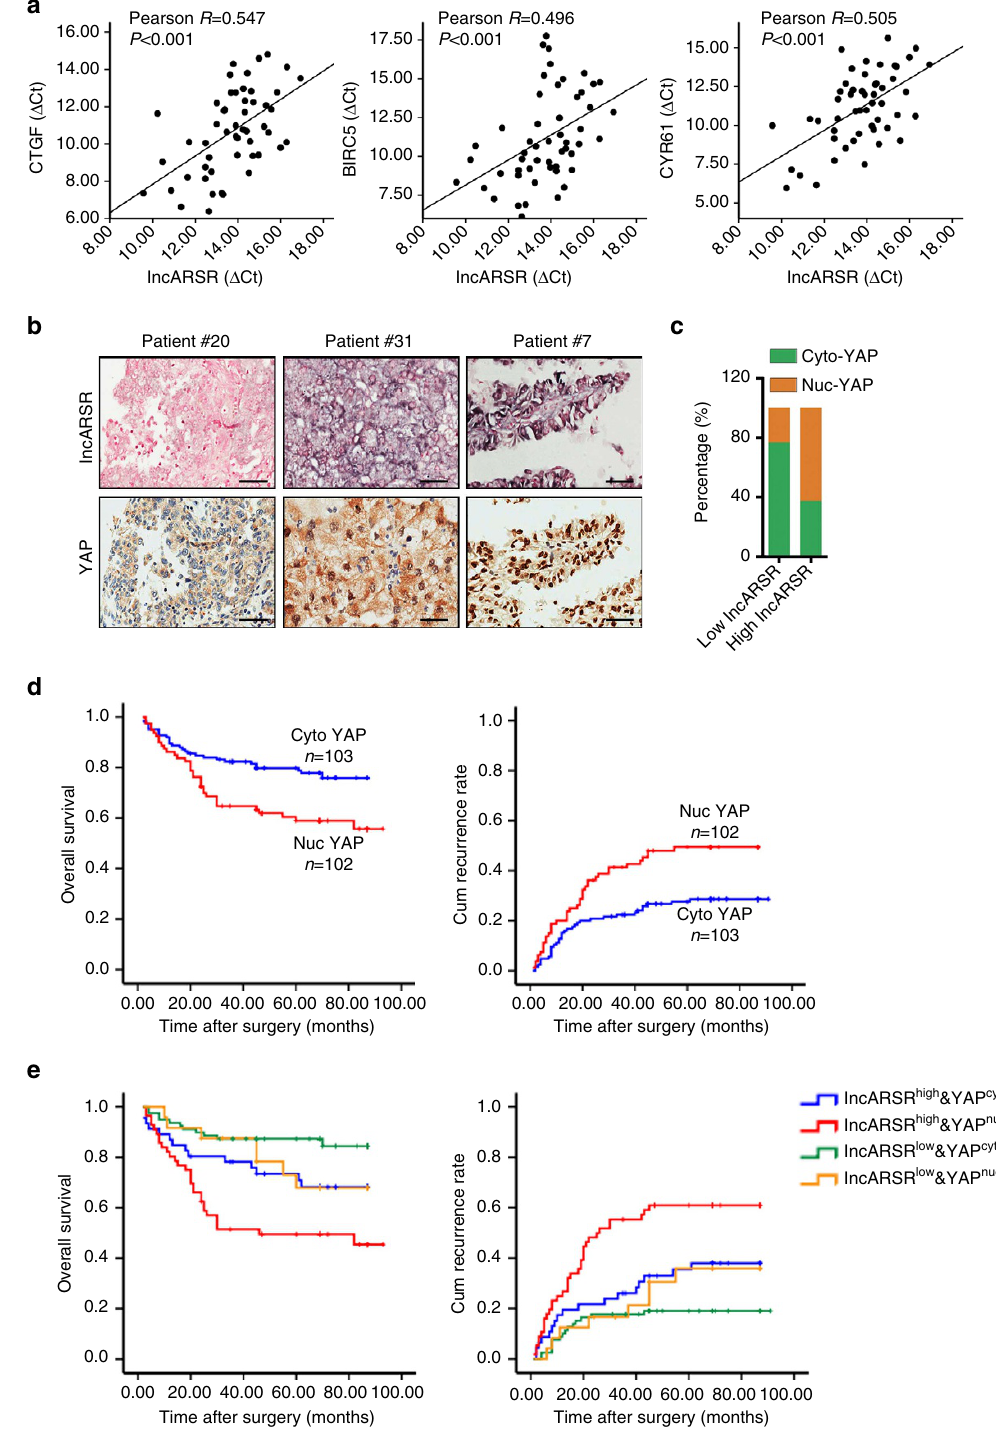
Figure 8 | Combining lncARSR and YAP exhibits improved prognostic value. ( a ) The correlation between the transcription level of lncARSR and CTGF (left), BIRC5 (middle) and CYR61 (right) in human ccRCC tissues ( n ¼ 52) was determined by qRT–PCR analysis. Data were normalized to b -actin as D Ct and analysed by Spearman’s correlation analysis. ( b ) Representative images of lncARSR ISH and YAP immunohistochemistry using consecutive sections of human ccRCC tissues. Scale bar, 50 m m. ( c ) Relative percentages of nuclear and cytoplasmic YAP in high (62.7%) and low (23.3%) lncARSR groups in cohort 2 ( P o 0.001). ( d ) Kaplan–Meier analysis of overall survival (left, P ¼ 0.005, log-rank test) or recurrence rate (right, P ¼ 0.002, log-rank test) of ccRCC patients with cytoplasmic or nuclear YAP in cohort 2. ( e ) Kaplan–Meier analysis of overall survival (left, lncARSR high YAP high versus lncARSR high YAP low , P ¼ 0.039, log-rank test; lncARSR low YAP high versus lncARSR low YAP low , P ¼ 0.093, log-rank test) or recurrence rate (right, lncARSR high YAP high versus lncARSR high YAP low , P ¼ 0.014, log-rank test; lncARSR low YAP high versus lncARSR low YAP low , P ¼ 0.173, log-rank test) of ccRCC patients with high or low lncARSR and cytoplasmic or nuclear